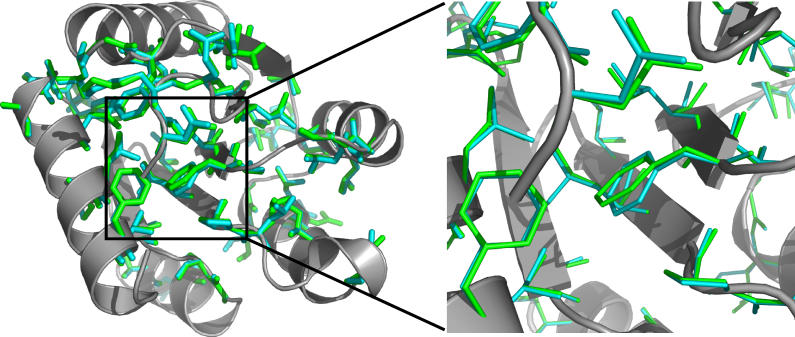
The Native (Green) and Redesigned (Cyan) Chey Protein (PDB: 3chy), Using Medusa Fixed-Backbone RedesignThe backbone structure is shown in cartoon, and the sidechains of recapitulated residues are shown in stick representation.